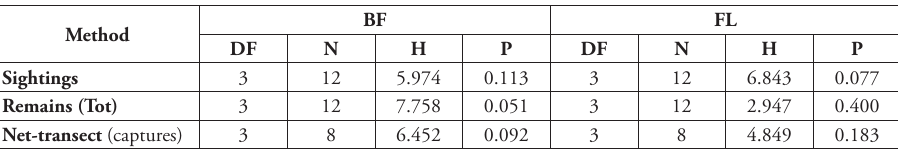
Table 5. Results of the Kruskal-Wallis test comparing the total number of contacts recorded during the 3 years (2014–2016) amongst the four transects at Bosco della Fontana (BF) and Foresta della Lama (FL), for three sampling methods (Tot = total counting).